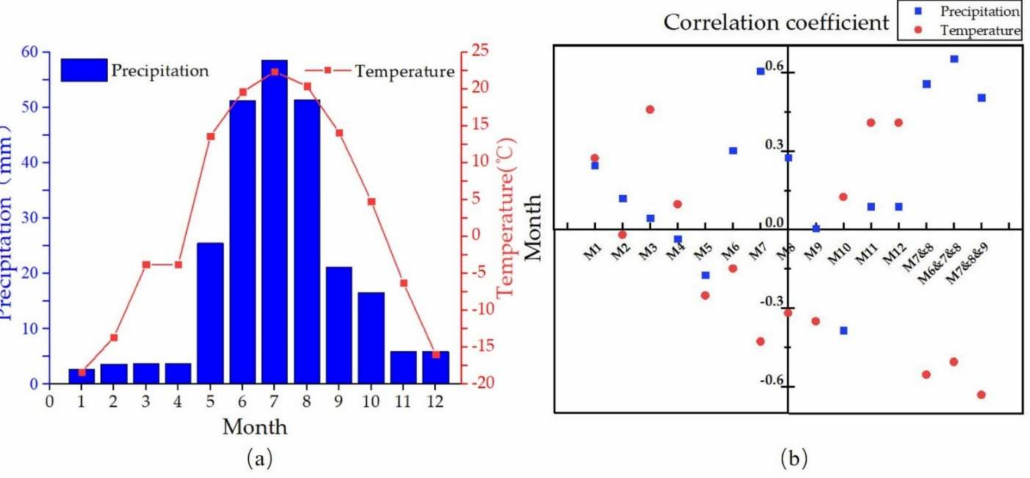
Figure 4. ( a ) The average precipitation and temperature from January to December during 2004 − 2020; ( b ) the correlation coefficient between FVC and precipitation and